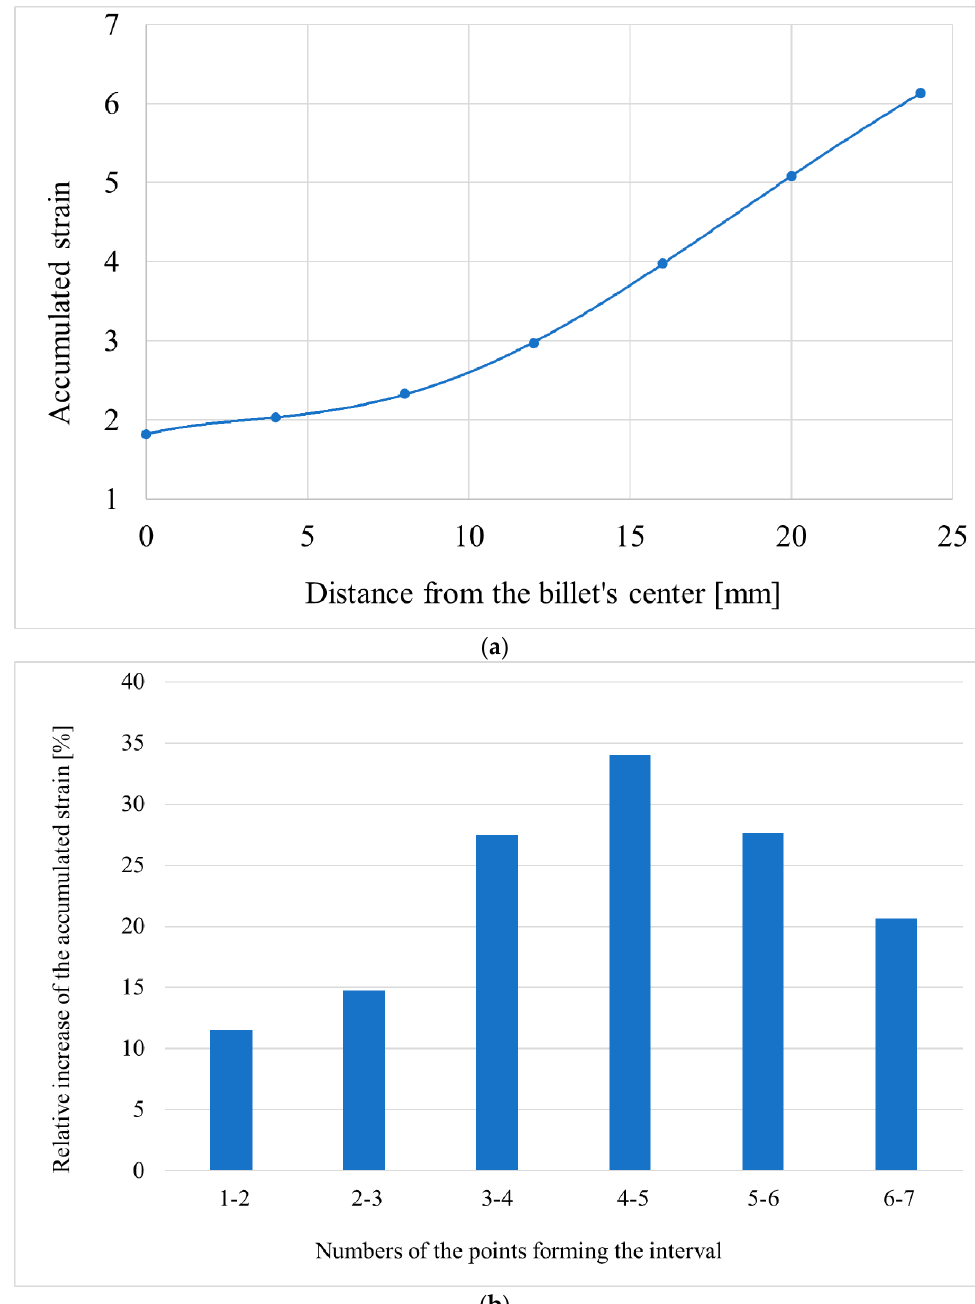
Figure 6. Variation in the accumulated strain along the rolled billet’s radius ( а ) and the relative in- crease in the accumulated strain in the intervals between tracked points ( b ) after computer simula- tion of all three passes.